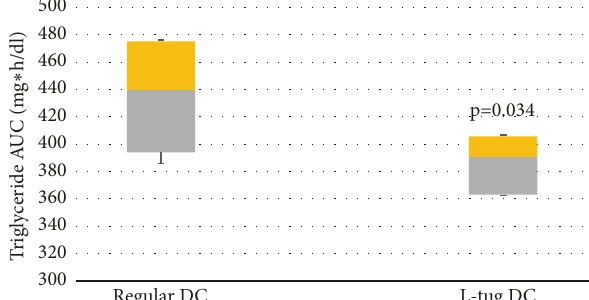
Figure 2: Changes in area under the curve (AUC) values for serum triglyceride concentration after ingestion of regular and L-tug